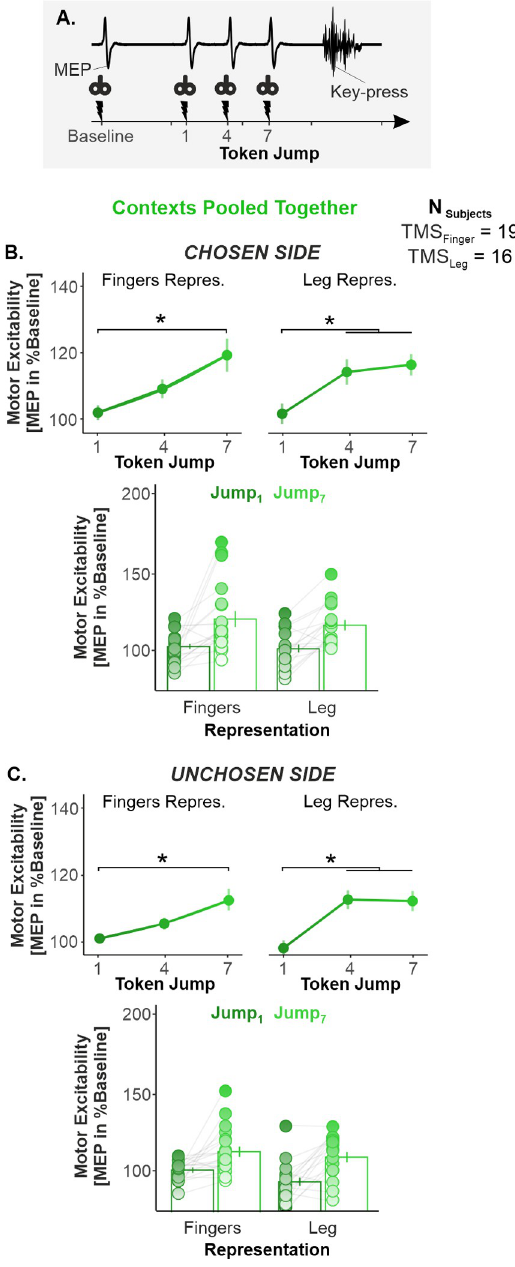
Fig 3. Motor excitability globally increased as time elapsed during deliberation. (A) TMS timings. We applied TMS at 4 timings during the task: at baseline (i.e., between the trials) and at Jump 1 , Jump 4 , and Jump 7 during the decision period. (B) Main effect of TIMING on motor excitability on the chosen side. To highlight the main effect of TIMING, both SAT contexts were pooled together. Further, the data obtained for the index, the thumb, and the pinky representations (top left) were averaged for the figure as well as the data obtained for the 3 leg representations (top right). The bar graph at the bottom displays the individual data points, as obtained at Jump 1 (dark green) versus Jump 7 (light green). Overall, this representation shows that a large proportion of participants exhibited an increase in motor excitability from Jump 1 to Jump 7 , both in the finger and in the leg representations. (C) Same as B. for the unchosen side. Error bars represent 1 SEM. � significant effect of timing at p < 0.05. All individual and group-averaged numerical data exploited for Fig 3 are freely available at this link: https://osf.io/tbw7h. SAT, speed–accuracy trade-off; TMS, transcranial magnetic stimulation.